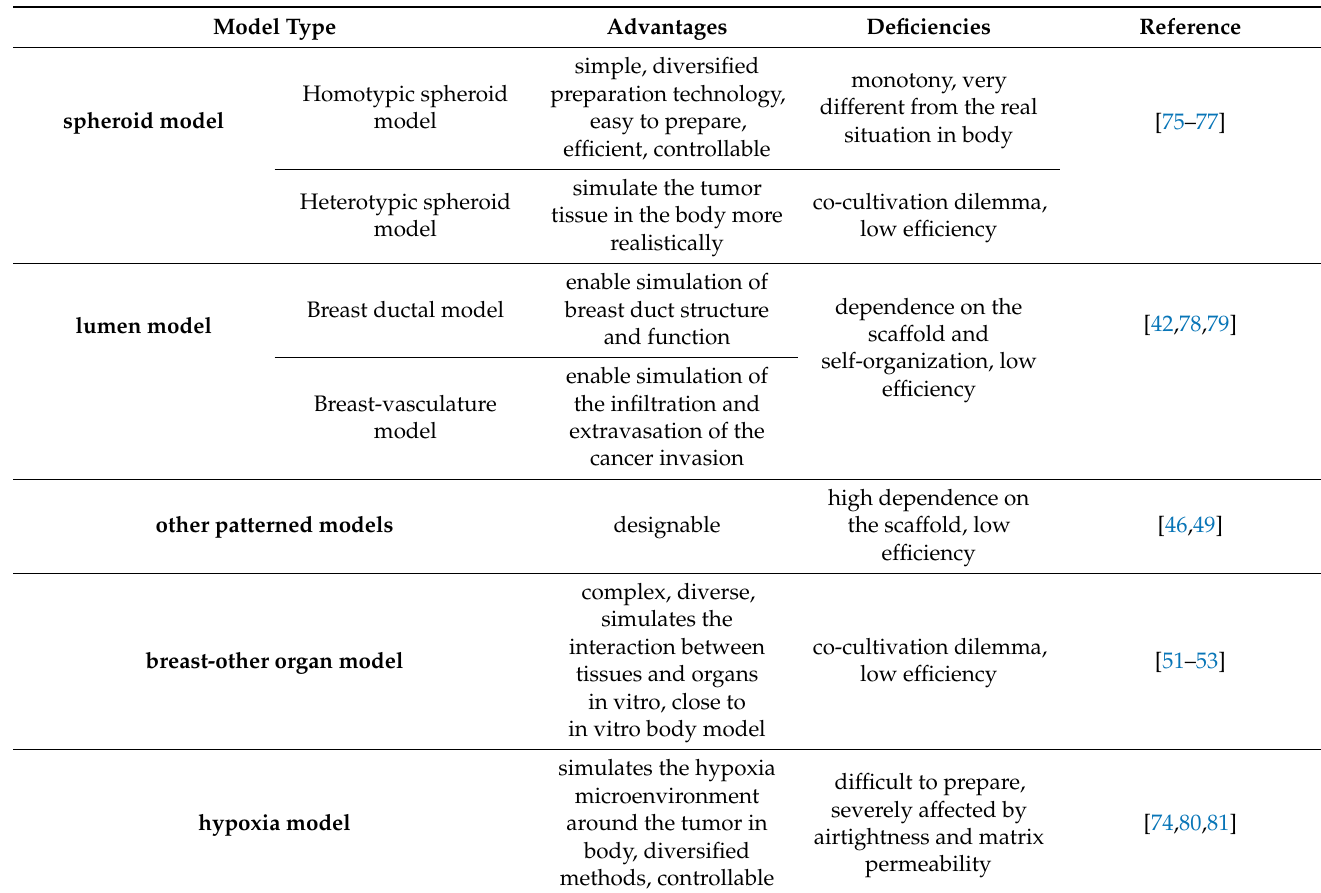
Table 1. The advantages and deficiencies of the breast models in breast tumor-on-a-chip. Model Type Advantages Deficiencies